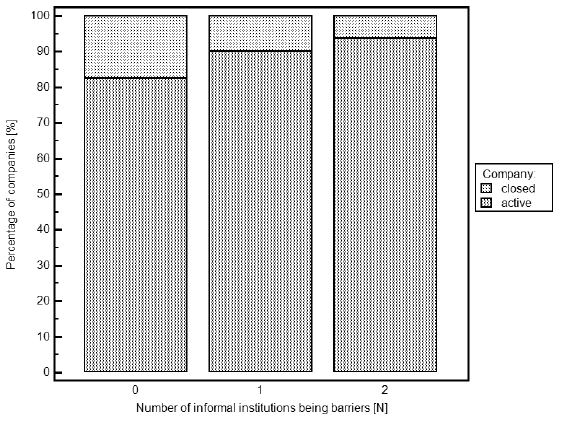
Figure 3. Number of informal institutions pointed out by managers as obstacles to the development of their companies (source: own elaboration) Later, the Kaplan-Meier survival analysis test was used to assess the relationship between the number of informal institutions perceived by managers and SMEs’ survival. Thus, the Kaplan-Meier curves were generated for each selected group of firms (Figure 4). These curves show that, up to 45 weeks, the survival of companies belonging to each group differed only slightly. However, from around the 50th week, the survival curves began to drift further apart. The differences between all curves turned out to be statistically significant (p = 0.0470; c2 = 6.1166). Hence, the more informal institutional barriers managers identified, the better were the chances of survival for SMEs. Therefore, hypothesis H2 has been confirmed.